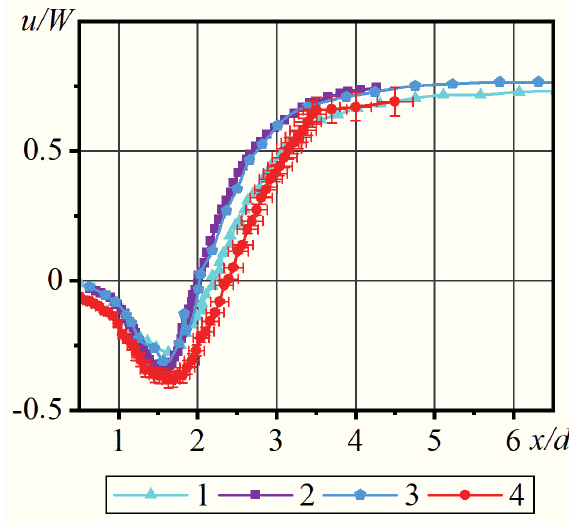
Figure 6. Longitudinal velocity component u in the cylinder wake: 1—LES results [10]; 2—SIV results [5]; 3—LES results [9]; 4—our